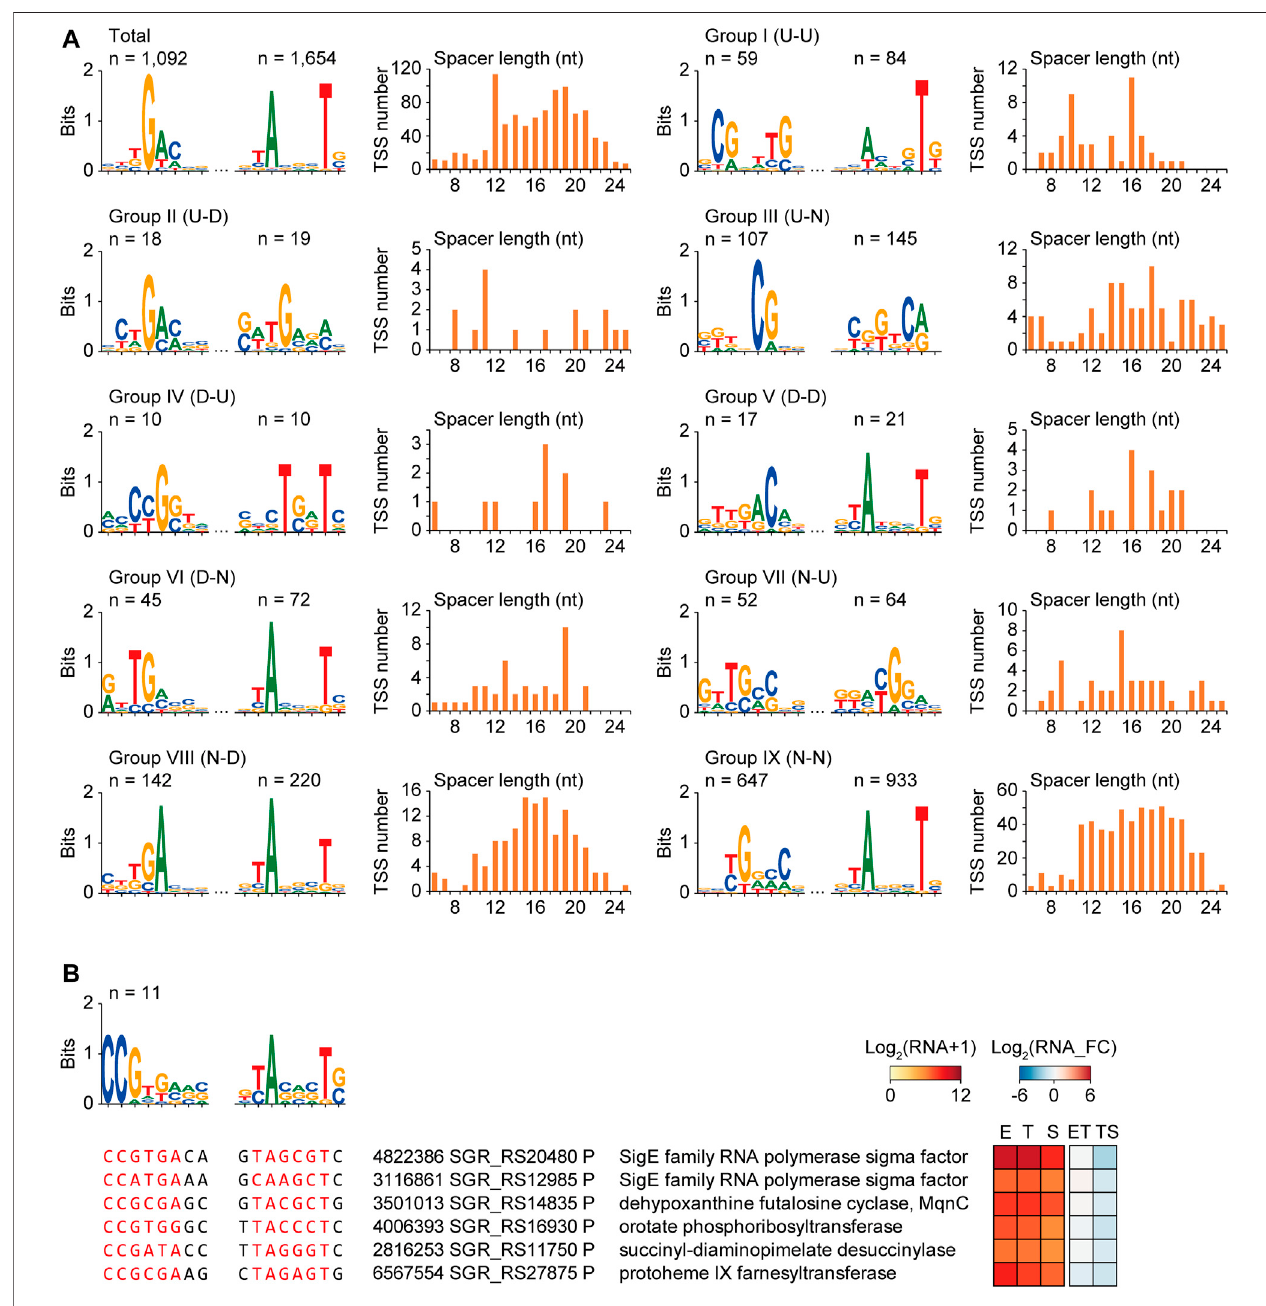
FIGURE 3 | Potential consensus sigma factor binding motifs for different transcription pattern groups. (A) The − 35 motifs, − 10 motifs, and spacer length distributions of the promoters of total TSSs and different transcription pattern group TSSs. (B) An example of the consensus sigma factor-binding motif of group VIII (N – D) group, including respective sigma factor. Sequence alignments, gene functions, and RNA expressions of six selected promoters were represented. The six promoters were selected based on the motif similarity with the sigma factor SGR_RS20480 by FIMO and MEME with low p -value of − 35 and − 10 motif, and their gene